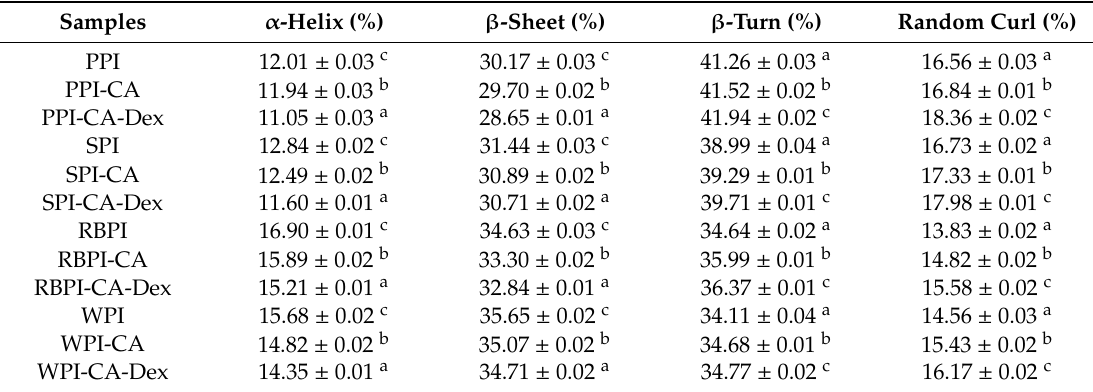
Table 1. The secondary structure contents of NP, PC, and PCD samples.